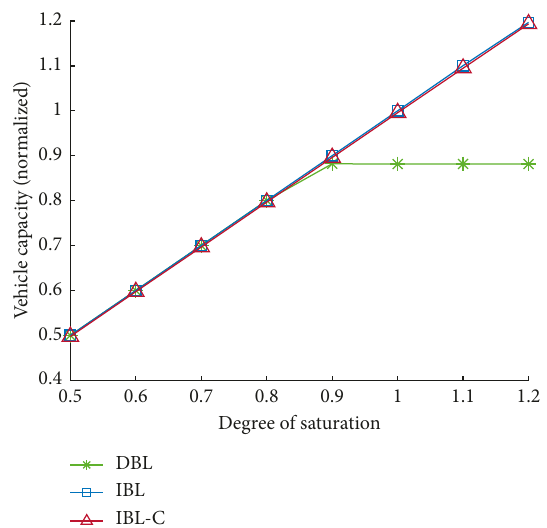
Figure 9: Average traffic flow volume when the interval of buses is